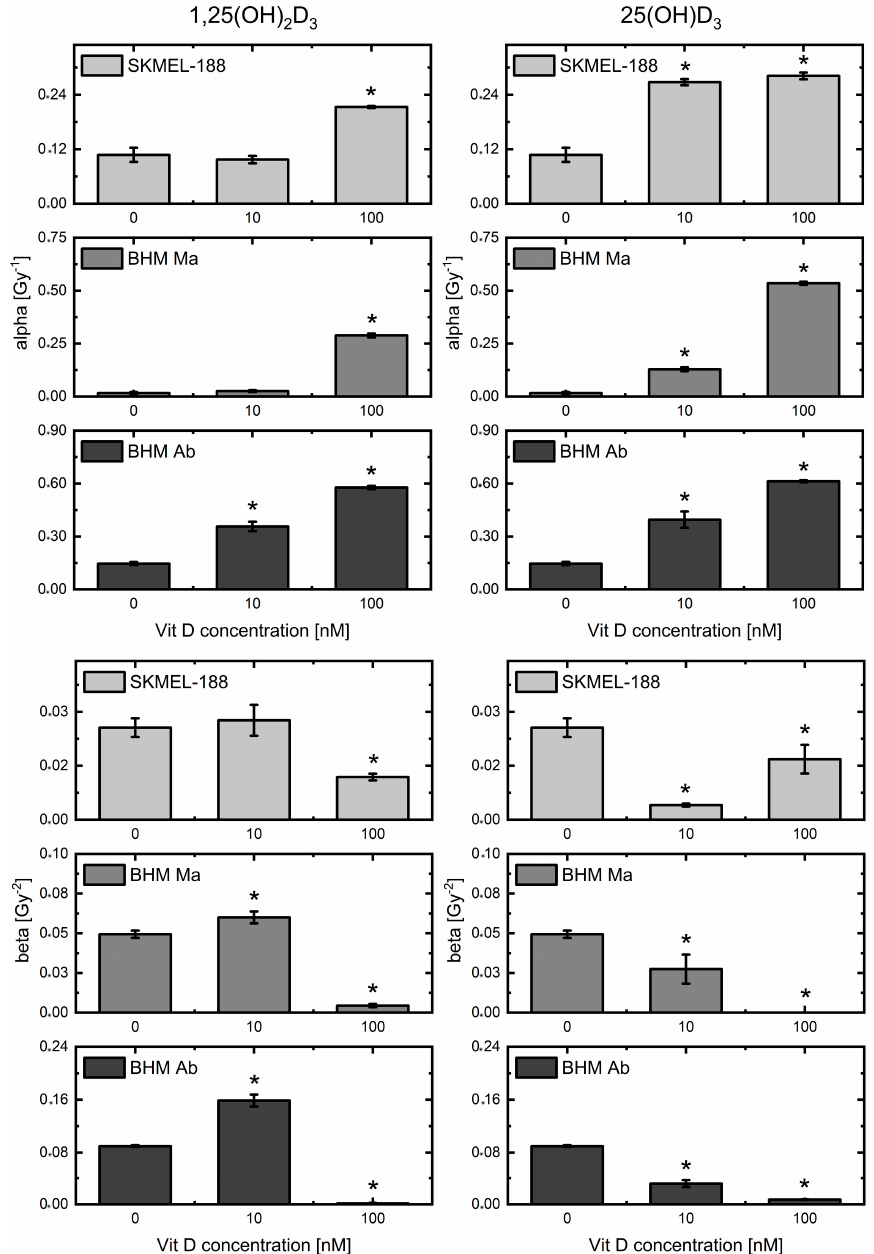
Figure 4. Coefficients α ( upper panel) and β ( lower panel) from linear-quadratic model calculated for cells pre-treated with calcitriol (1,25(OH) 2 D 3 ) and calcidiol (25(OH)D 3 ) and irradiated with proton beam. Surviving fraction was determined from the model described by Buch et al. [34], based on the experimental data from SKMel-188, BHM Ma and BHM Ab cell number, counted every 24 h for 4 days in culture after irradiation. * denotes statistical significance p < 0.05 against control (0 nM of vitamin D 3 derivative).